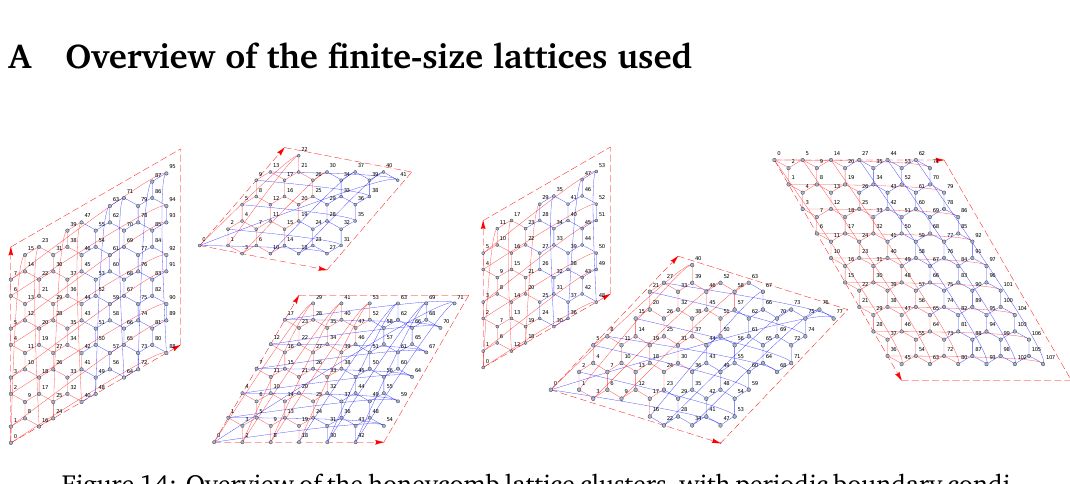
Figure 14: Overview of the honeycomb lattice clusters, with periodic boundary condi- tions, that have been used for exact diagonalization and dynamics. The red and blue subsystems correspond to the ones used for entanglement entropy